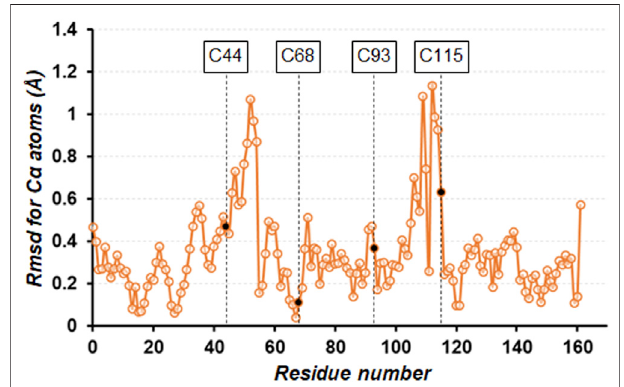
FIGURE 2 | Plot of the rmsd values for C α atoms of the cross-linked SNAT-T4L structure with respect to that of TA (PDB ID: 5VNR). The four mutation sites are indicated by black circles.